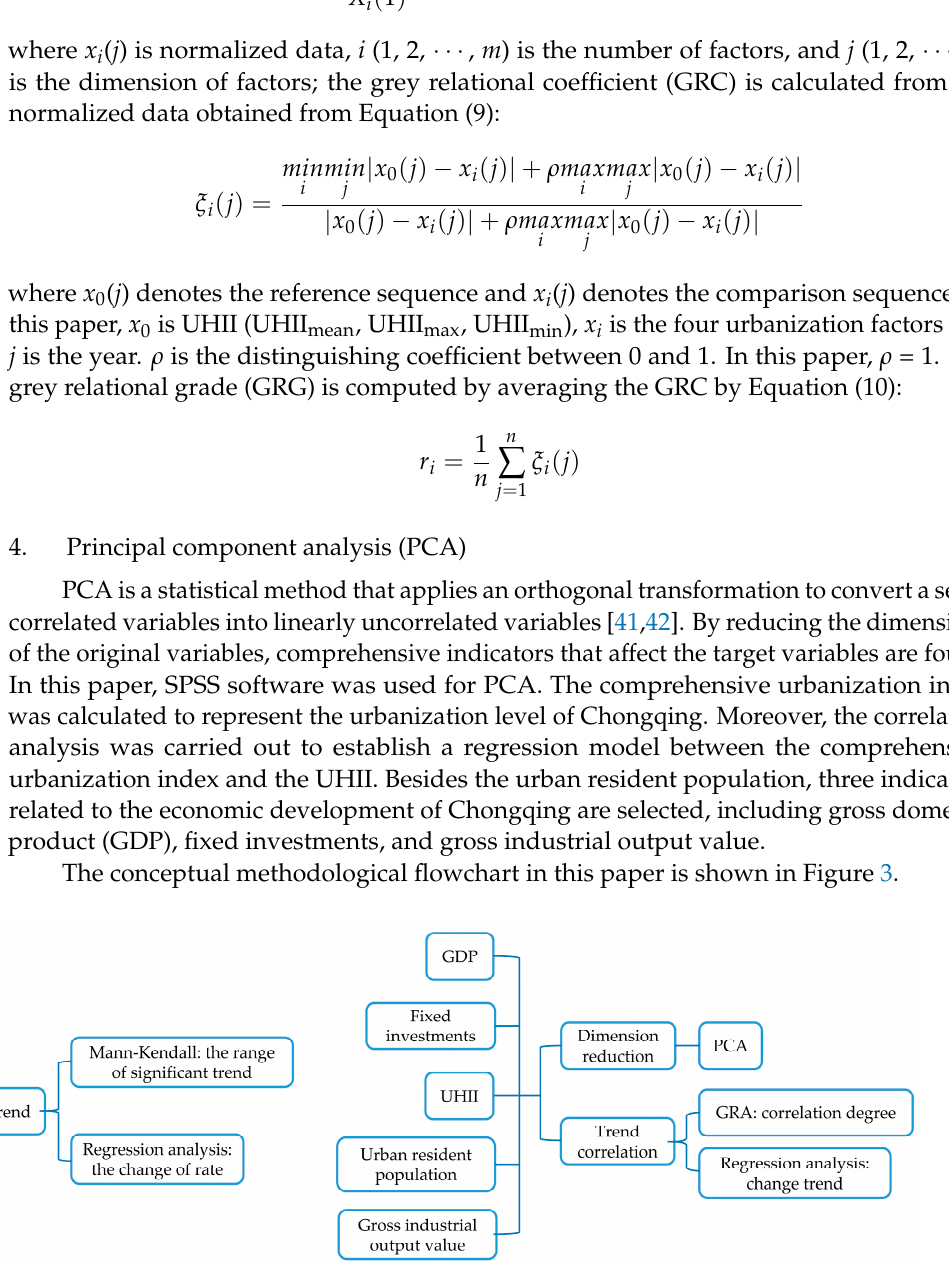
Figure 3. The conceptual methodological flowchart .